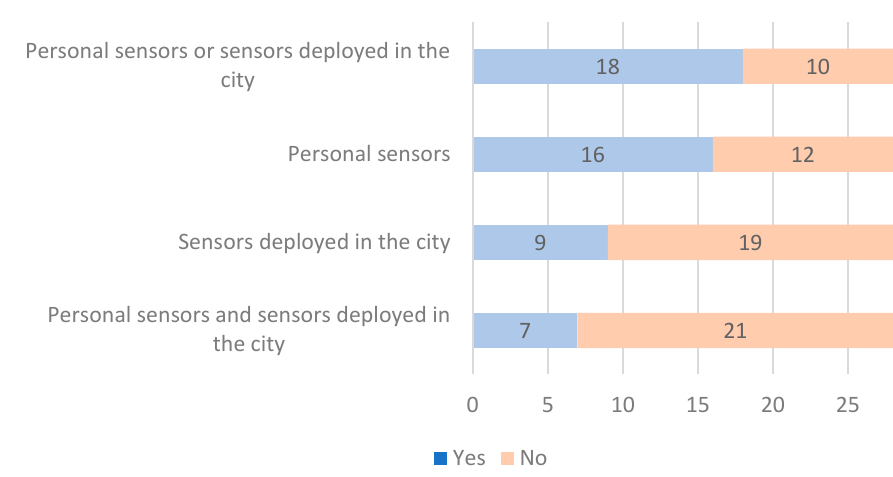
Table 5. Open data from the smart city. Type of Data